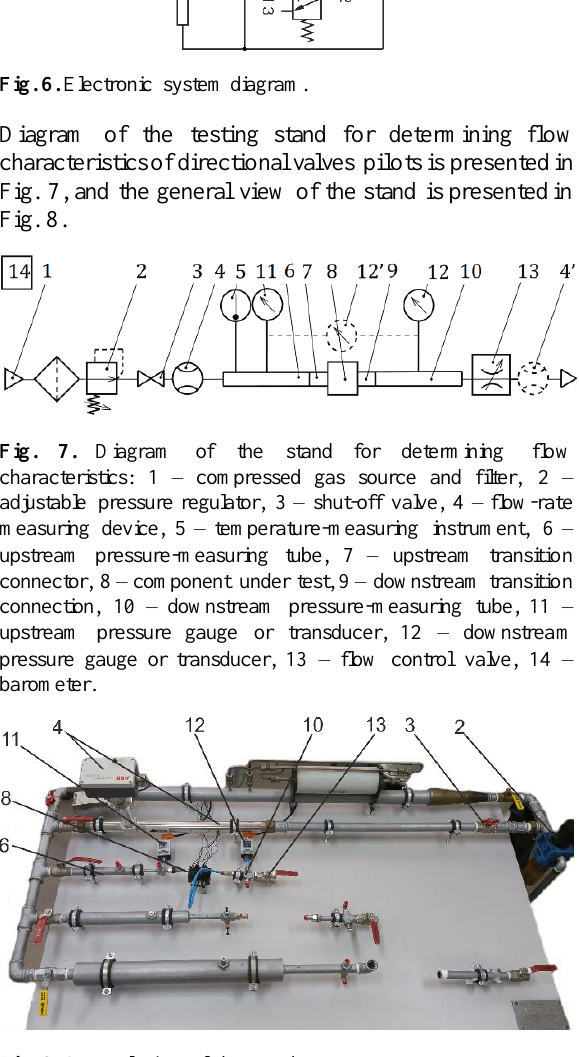
Fig. 8. General view of the stand.